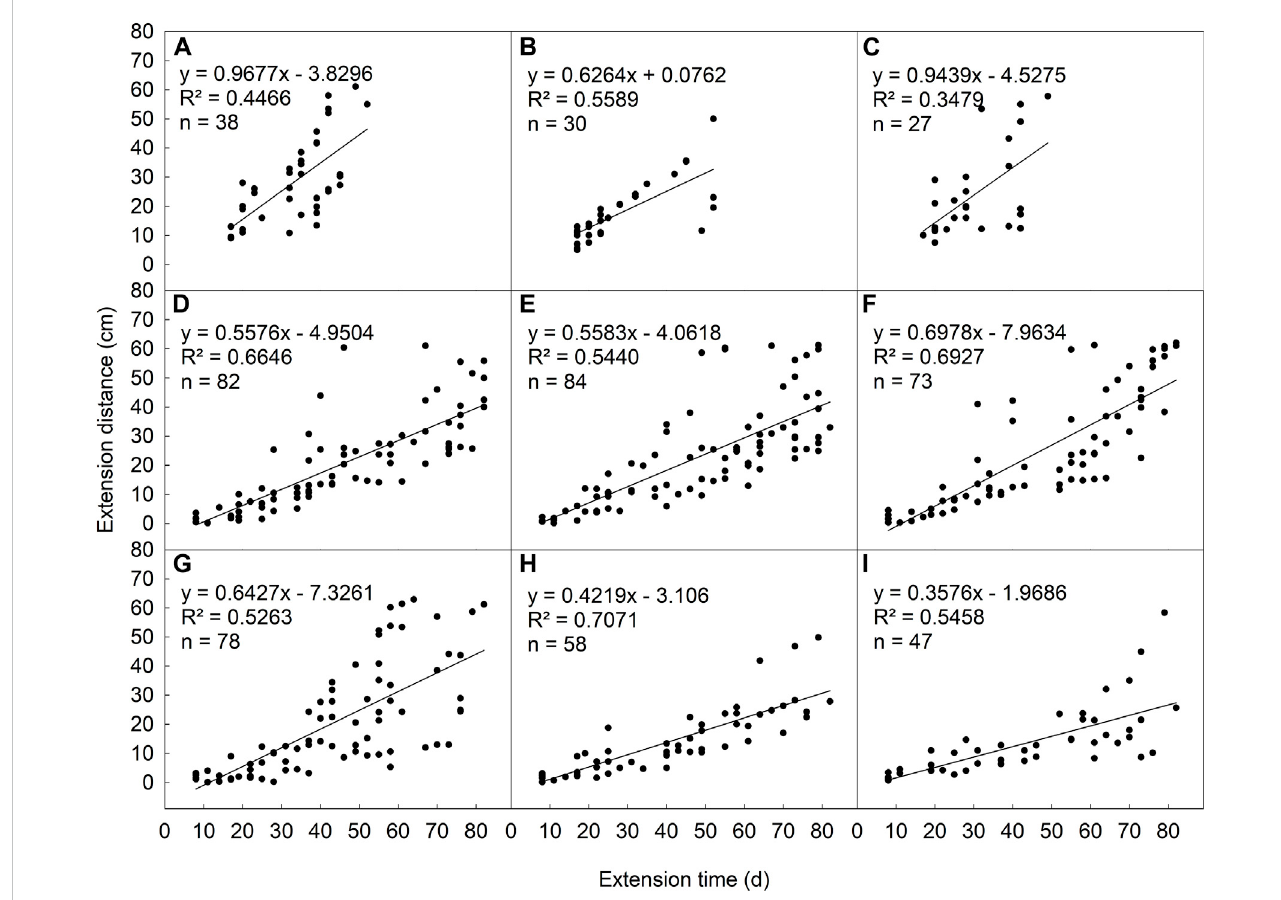
FIGURE 4 The relationship between extension distance and time of L. chinensis rhizome under different saline-alkali and clipping stress: homogeneity and no clipping (A) ,homogeneityandmoderateclipping (B) ,homogeneityandheavyclipping (C) ,lowsaline-alkaliheterogeneityandnoclipping (D) ,lowsaline-alkali heterogeneity and moderate clipping (E) , low saline-alkali heterogeneity and heavy clipping (F) , high saline-alkali heterogeneity and no clipping (G) , high saline-alkali heterogeneity and moderate clipping (H) , high saline-alkali heterogeneity and heavy clipping (I)